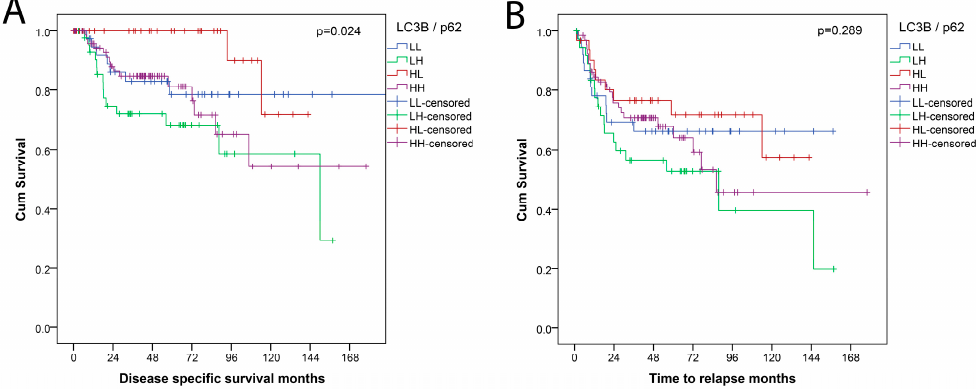
Figure 4. Survival curves for combination LC3B/p62 categorization into four subgroups: LL = LC3B low p62 low ; LH = LC3B low p62 high ; HL = LC3B high p62 low ; HH = LC3B high p62 high ; ( A ) disease specific survival (DSS); ( B ) time to relapse (TTR). Table 1. Results of multivariate analysis including pT, pN, and M category. Factor